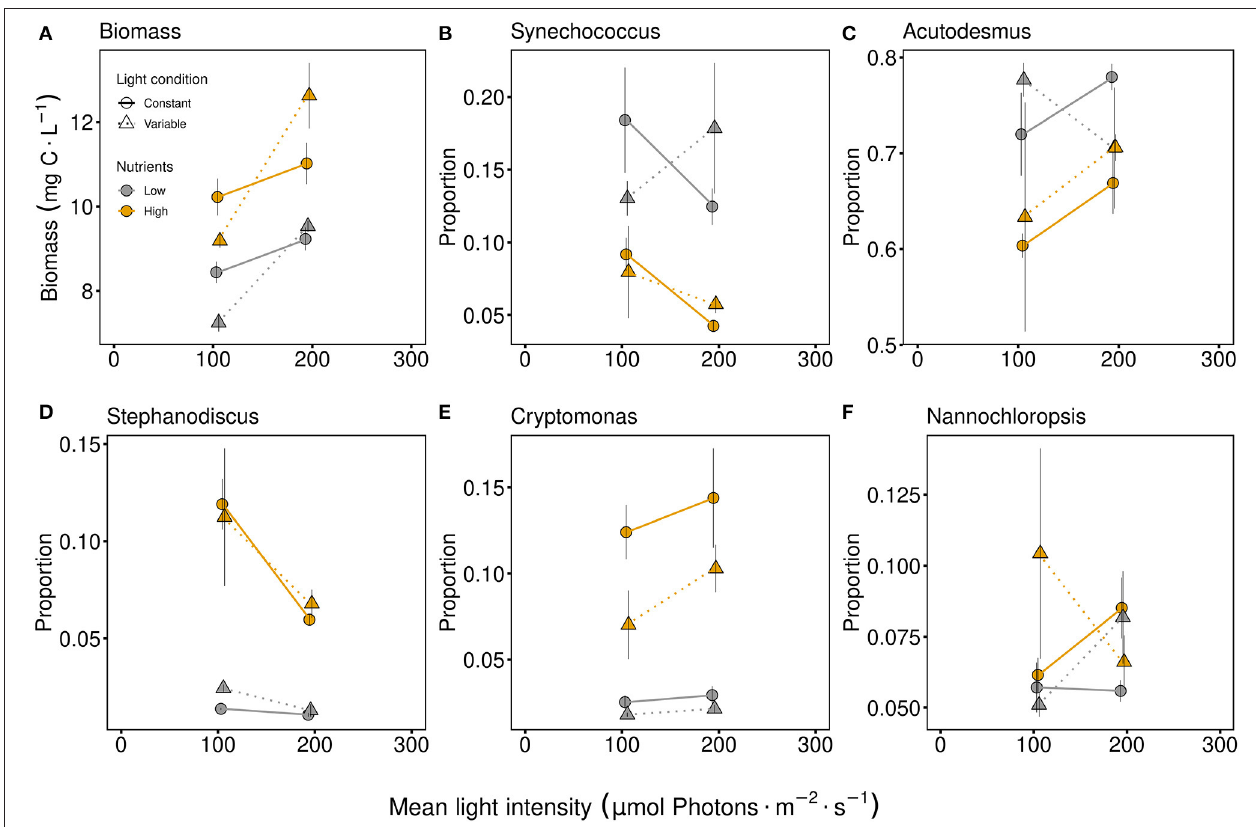
FIGURE 3 | Total biomass [mg carbon per liter; (A) ] and proportions of specific species in the community after six or eight days of interspecific competition and acclimation to light and P conditions. The genus names of Synechococcus elongatus (B) , Acutodesmus obliquus (C) , Stephanodiscus hantzschii (D) , Cryptomonas ovata (E) , and Nannochloropsis limnetica (F) are used in the figure titles. Communities were either cultivated under variable (triangles, dashed line) or constant (circles, solid line) light conditions. Mean values are shown for high (orange symbols and lines) and low (gray symbols and lines) nutrient supply and are displayed with ± standard error. Additional barplots of the species proportion are given in Supplementary Figure 4